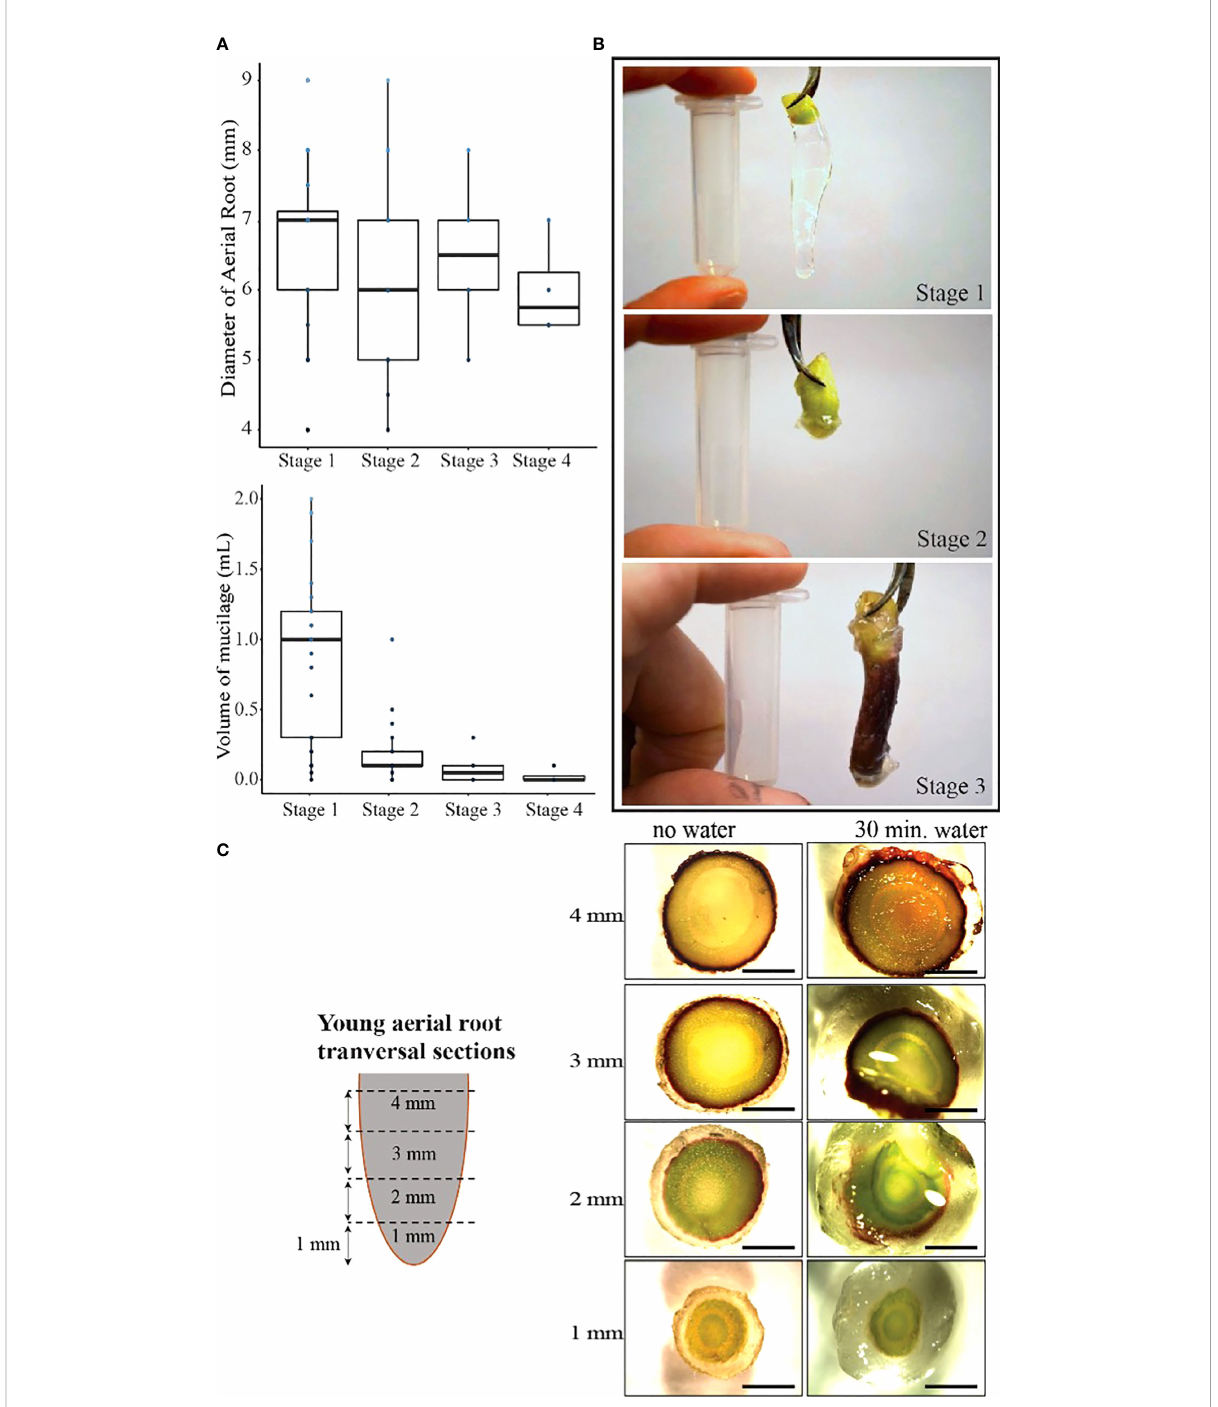
FIGURE 2 Younger aerial roots produced more mucilage and were categorized into three stages. (A) The diameter of aerial roots does not change during plant development, but the amount of mucilage produced does change. (B) Stage 1 roots are shorter and produce up to 1.5 mL of mucilage. In stage 2, roots still produce mucilage up to 0.5 mL, and in stage 3, the root cap starts to detach from the aerial root, and mucilage is no longer produced. Stage 4 has no visible root cap and does not produce mucilage. The 2 mL tube in the picture was 4 cm long. (C) The root tip of the aerial root produces more mucilage than the base of the root, and water is necessary to contact the aerial root to stimulate the secretion of